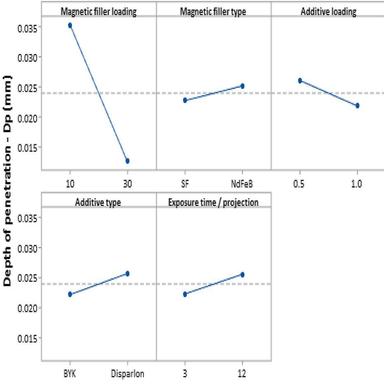
Main effects plots representing mean of depth of penetration (Dp).